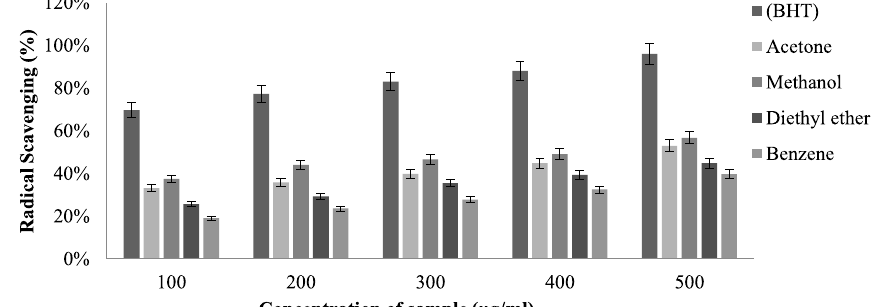
Fig. 7 DPPH radical scavenging activity of P. dendritica in various solvent extractions